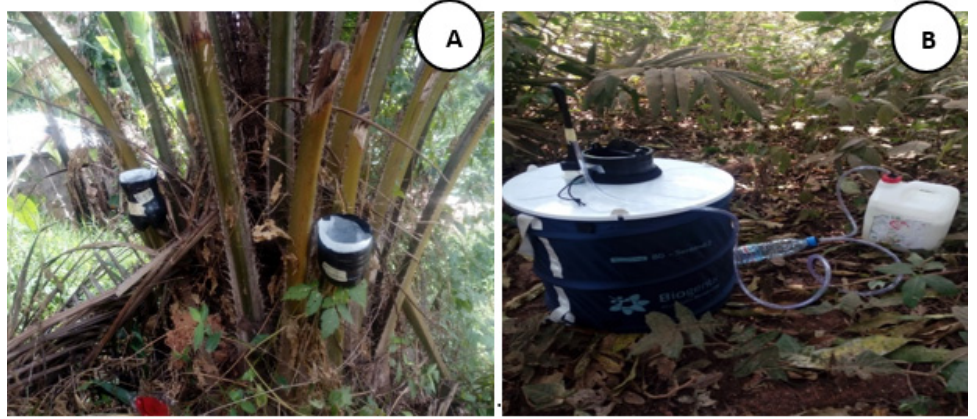
Figure 2. Illustrative image of ovitrap ( A ) and Biogent Sentinel trap ( B